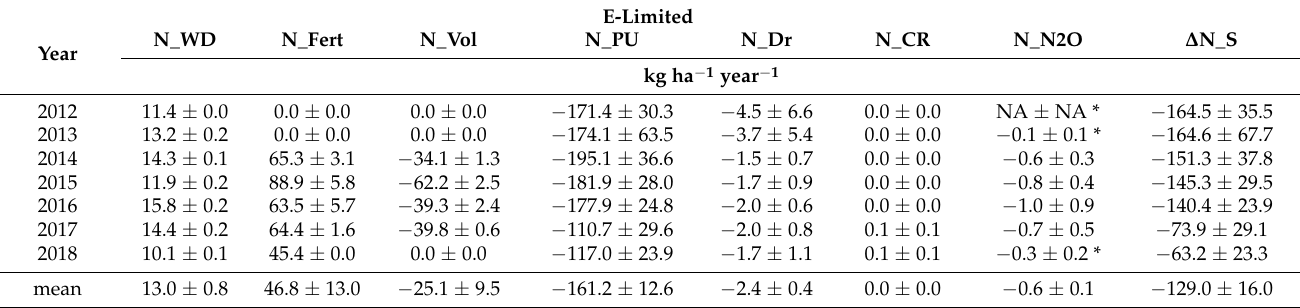
Table A4. Components of the lysimeter soil nitrogen balance—mean values and standard deviations, ± , in kg ha − 1 year − 1 — for Rollesbroich soil in Rollesbroich, the energy-limited site (E-limited) between 2012 and 2018 with the wet deposition (N_WD), applied fertilizer (N_Fert), volatilization of the fertilizer nitrogen (N_Vol), plant nitrogen uptake (N_PU), nitrogen in drainage (N_Dr), nitrogen in capillary rise (N_CR), gaseous nitrous oxide nitrogen (N_N 2 O), and change in soil nitrogen storage ( ∆ N_S); negative values represent a loss of nitrogen for the system; column “mean” indicates the means of the annual values for the period 2012–2018 and the inter-annual variability is represented by the standard error of annual means. NA stands for Not Available.